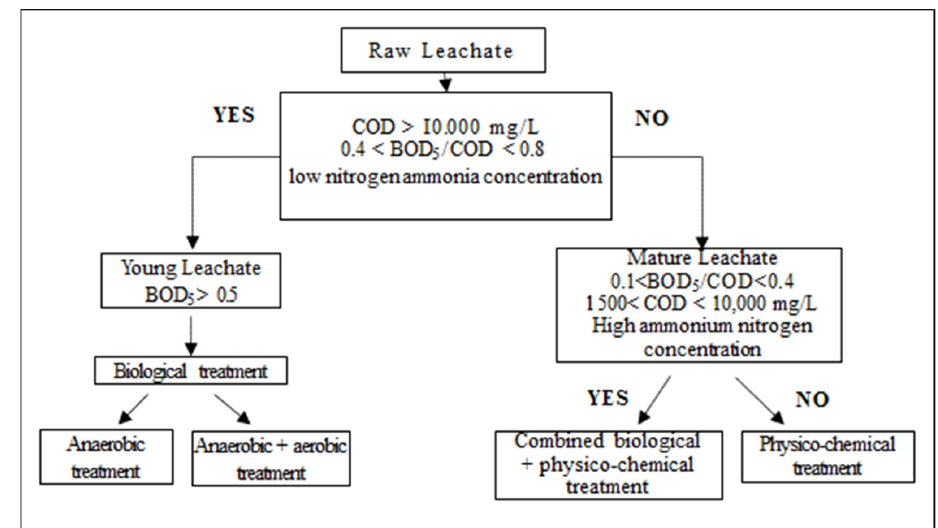
Figure 6. A typical leachate treatment selection protocol. Source [21]. Table 6. Leachate physicochemical treatment system benefits and